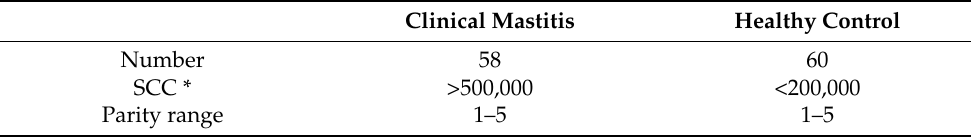
Table 1. Information of the parity and health status of the samples used in the study.